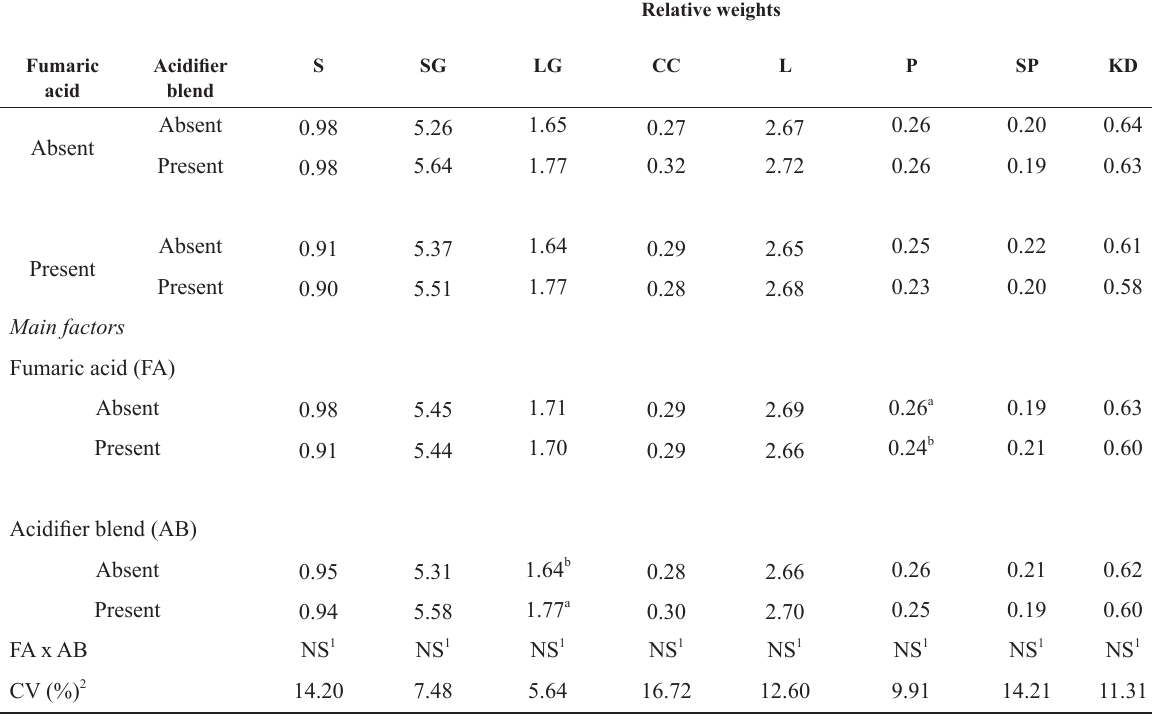
Mean of organ’s relative weights calculated based on empty weight of piglet’s